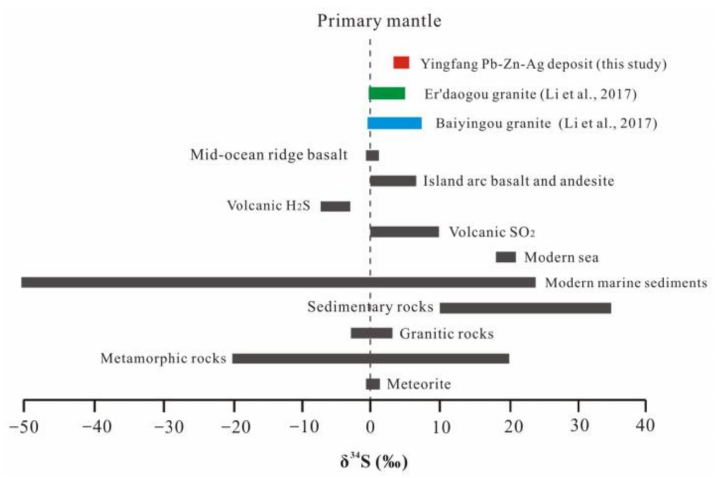
Figure 7. Sulfur isotopic composition of sulfides and granites from the Yingfang deposit (after